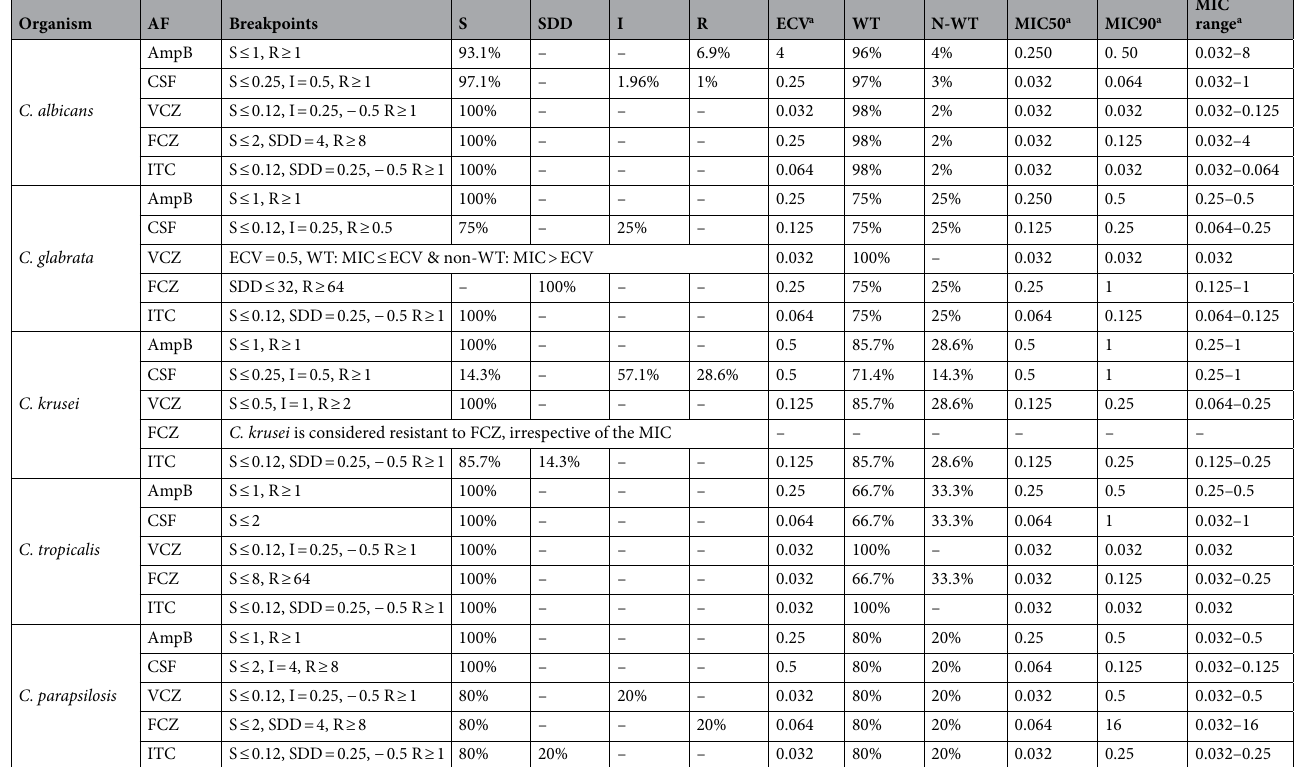
Table 2. Susceptibility of 131 Candida spp. to antifungal drugs and distributions of MIC (µg/ml) by CLSI broth microdilution method. Based on recommended CLSI 24-h minimum inhibitory concentration limits. AmpB Amphotericin B, CSF Caspofungin, VCZ Voriconazole, FCZ Fluconazole, ITC Itraconazole, AF antifungal, SDD susceptible dose-dependent, S sensitive, I intermediate, R resistant, ECV Epidemiological Cutoff Value; ECVs capture ≥ 97.5% of the statistically modelled population, WT Wild-type, NWT non-wild- type, MIC50 Minimum Inhibitory Concentration required to inhibit the growth of 50% of organisms, MIC90 Minimum Inhibitory Concentration required to inhibit the growth of 90% of fungal species. a (µg/ml).